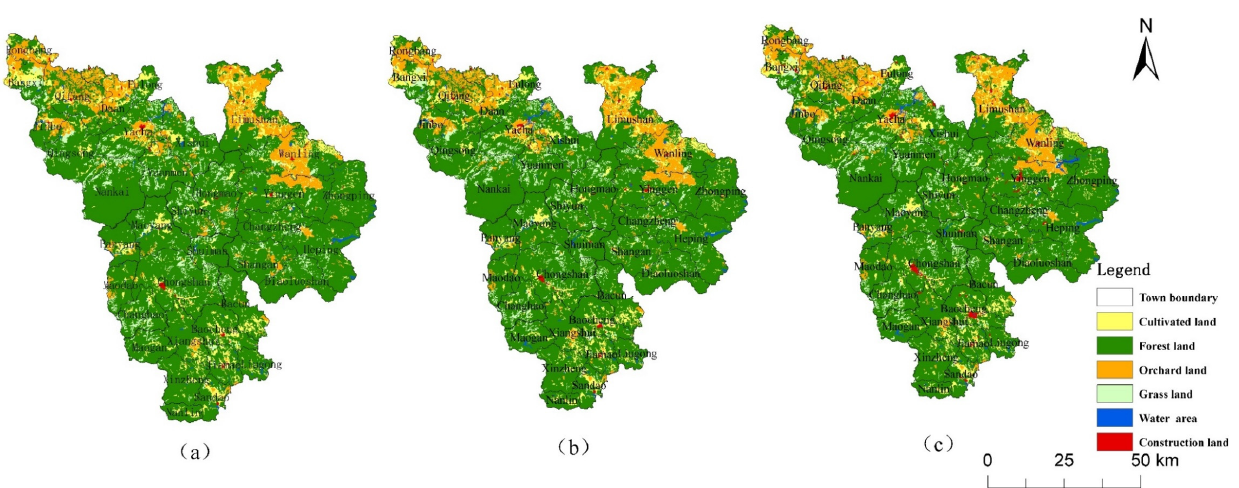
Figure 3. Land-use change from 2000 to 2018. ( a ) CMA ( b ) Qiongzhong (1—cultivated land; 2— forest land; 3—orchard; 4—grassland; 5—water area; 6—construction land). Table 3. Land-use changes in CMA from 2000 to 2018.